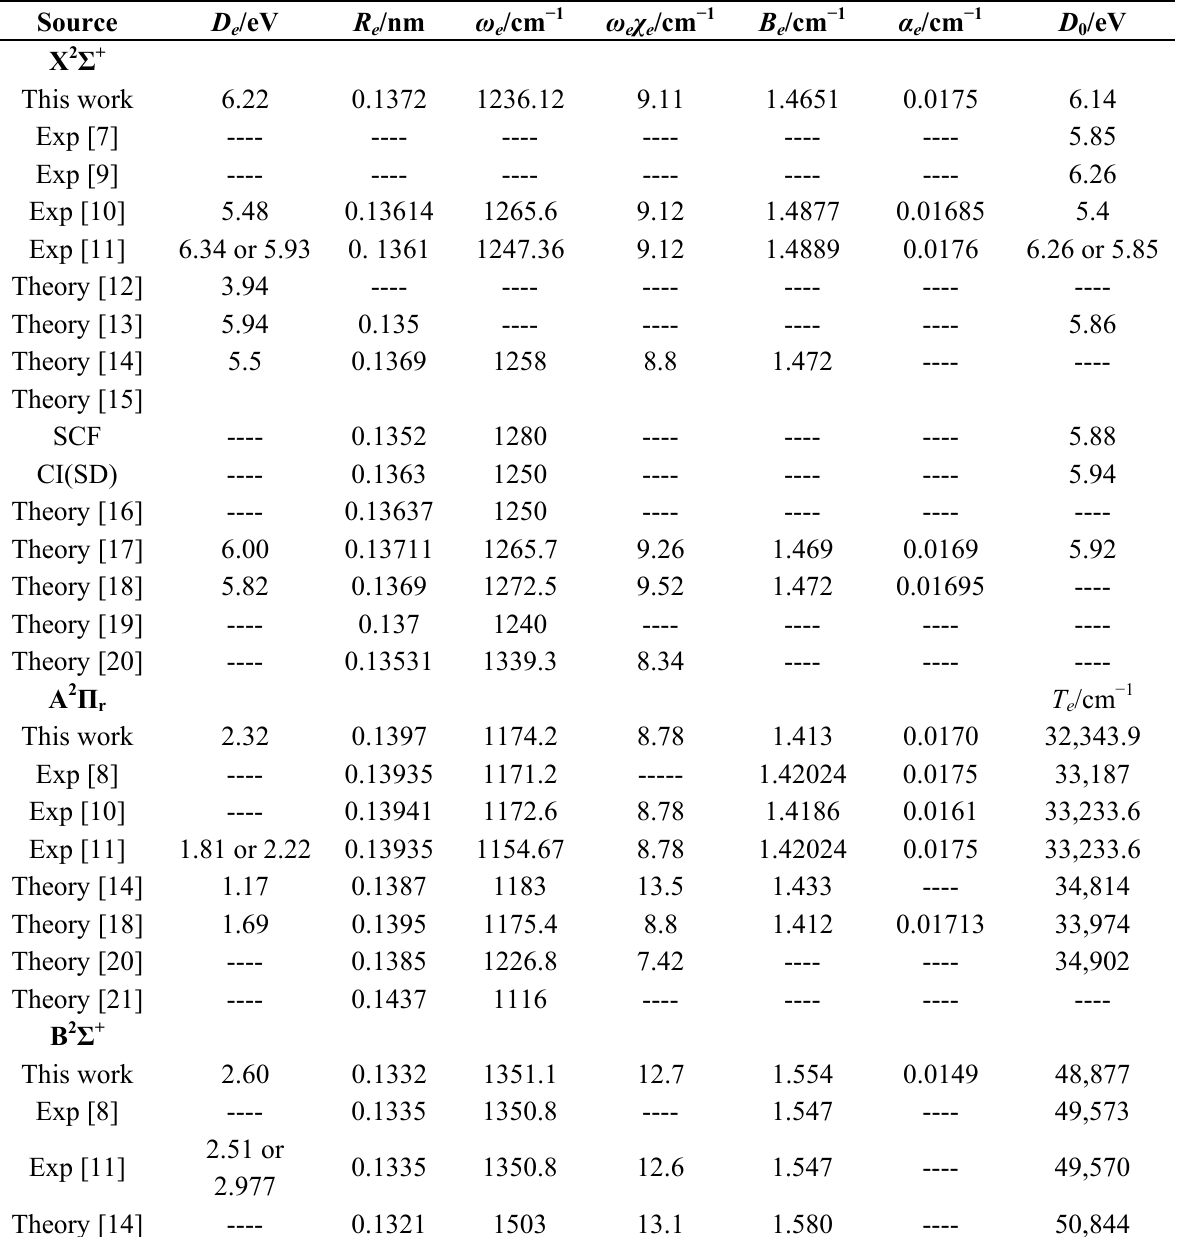
Table 1. Spectroscopic parameter comparison with available measurements and other theories for BeF